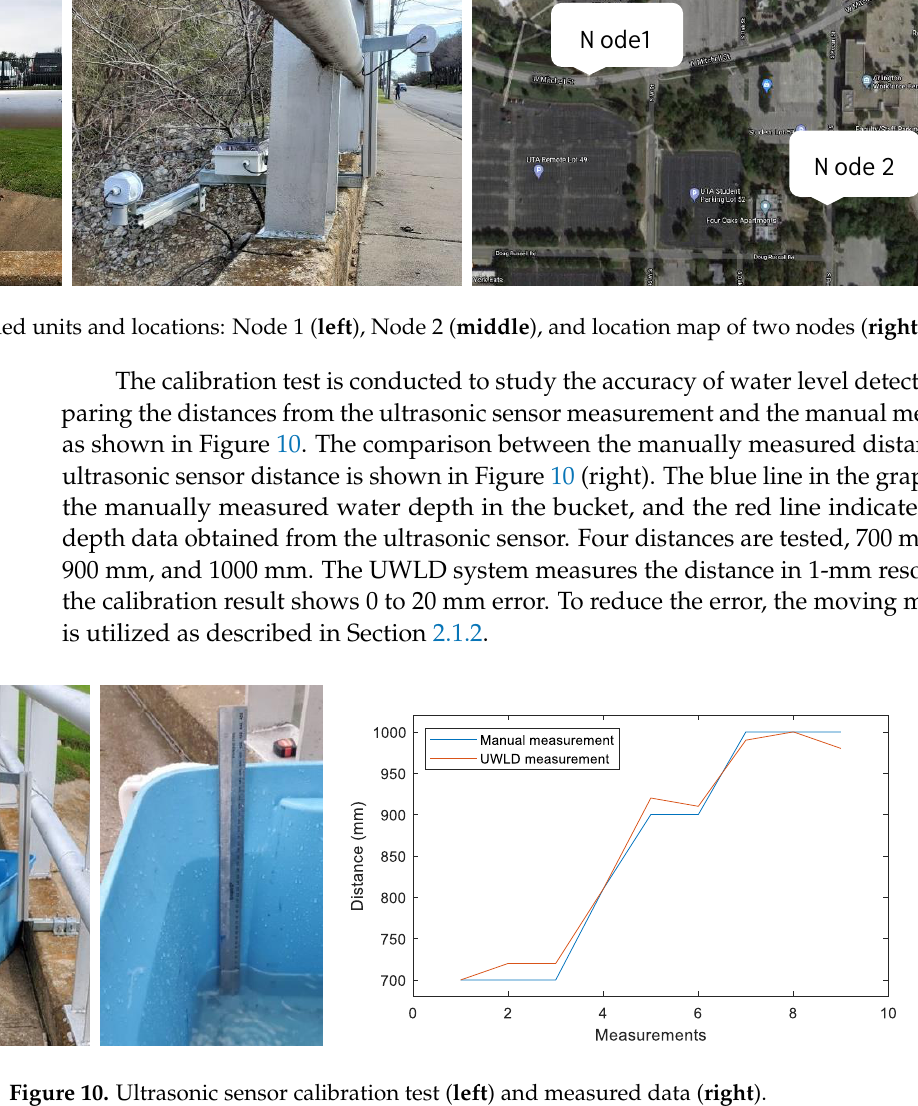
Figure 8. Flowchart of the UWLD system with dual-target sensing and dual MCUs (UWLD-3).